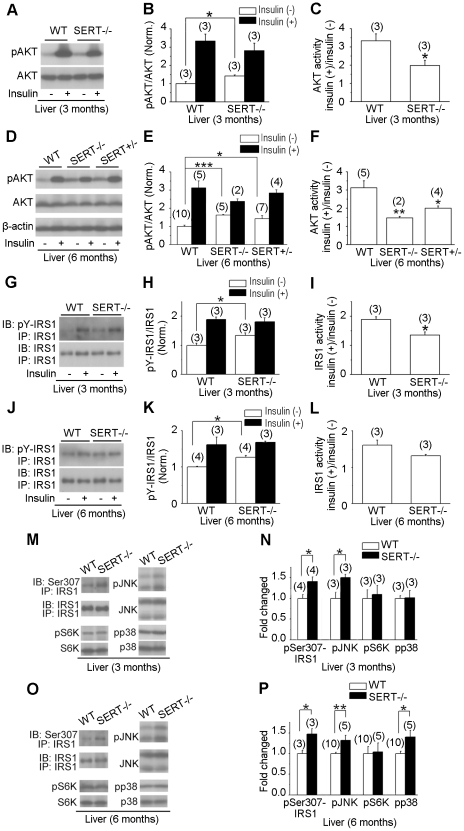
Western blot analysis of insulin signaling component activity in SERT-deficient mice.
A–F. AKT activity in the liver of 3- and 6-month old WT and SERT-deficient mice was evaluated by western blot analysis of AKT Ser473 phosphorylation (pAKT) before and after insulin injection. G–L. IRS1 activity in the liver of 3- and 6-month old WT and SERT-deficient mice was evaluated by western blot analysis of tyrosine-phosphorylated IRS1. IRS1 was first immunoprecipitated with anti-IRS1 antibody (IP-IRS1) and then blotted with anti-IRS1 (IB-IRS1) or anti-phosphotyrosine antibodies (IB-pY-IRS1). A, D, G and J show images of representative western blot results. B and E show densitometric quantification of the ratio of pAKT vs. total AKT, and H and K show densitometric quantification of the ratio of pY-IRS1 vs. total IRS1. Insulin (−), basal activity determined from the tissues collected from16 h fasted mice. Insulin (+), insulin-induced activity determined from the tissues collected from mice 20 min post insulin injection. The value of WT treated with insulin and mutants with and without insulin treatment is normalized to that of WT without insulin treatment. C and F show the ratio of pAKT before and after insulin injection for each genotype. I and L show the ratio of pY-IRS1 before and after insulin injection. The basal pAKT and pY-IRS1 were elevated, but the net increase in pAKT and pY-IRS1 following insulin injection was attenuated in SERT mutant mice. M–P. Western blot analysis of phospho-Ser307-IRS1, phospho-JNK (pJNK), phospho-S6K (pS6K), and phospho-p38 MAPK (pp38) in the liver of 16 h fasted 3- and 6-month old SERT mutant mice. M and O show images of representative western blot results. N and P show densitometric quantification of pSer307-IRS1, pJNK, pS6K and pp38. The amounts of phosphorylated proteins are normalized to that of total corresponding proteins. Shown are the relative values of SERT−/− mice to WT, with the average value from WT mice defined as 1. Data represent mean ± SEM, *p<0.05, **p<0.01, Student's t-test. The number of mice analyzed is indicated in parentheses.